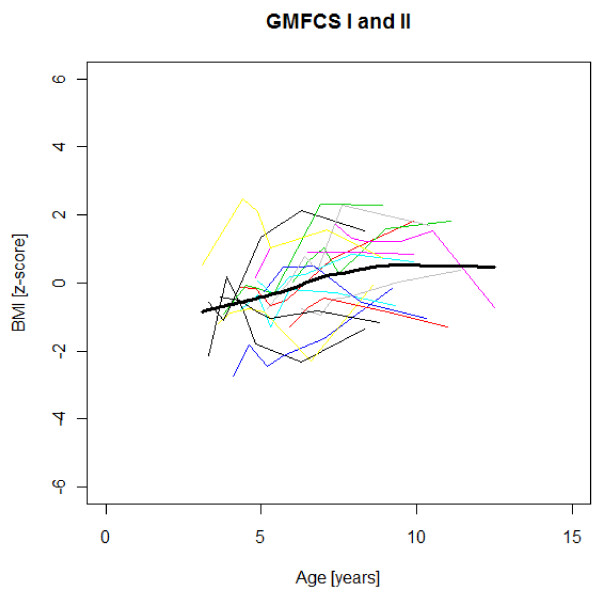
BMI z-scores in GMFCS I-II. BMI z-score at different age in 17 children with CP spastic diplegia, GMFCS I-II. Their mean z-score development with age is shown in black.